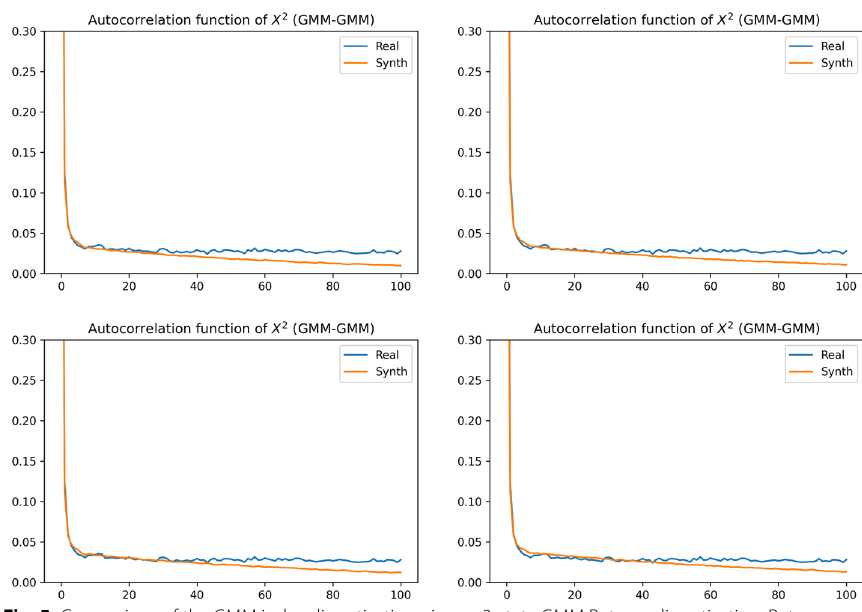
Fig. 5 Comparison of the GMM index discretization given a 3-state GMM Returns discretization. Returns at 1-s interval. 3-state index (top-left), 4-state index (top-right), 5-state index (bottom-left), 9-state index